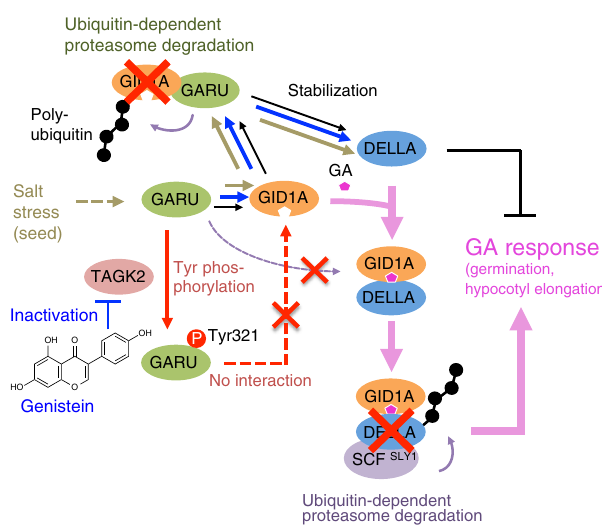
Fig. 8 A proposed model for control of GID1A protein stability by GARU- dependent ubiquitination and TAGK2-dependent Tyr phosphorylation. GARU induces ubiquitin-dependent proteasome degradation of GID1A (black lines). Destabilization of GID1A causes the stabilization of the DELLA, and GA signal is suppressed. However, GARU cannot ubiquitinate GA – GID1A – DELLA complex (purple dotted line), indicating that GA- dependent complex formation is more predominant than GID1A degradation by GARU. GARU – GID1A interaction is regulated by TAGK2- dependent Tyr phosphorylation of Tyr321 residue on GARU (red lines). In addition, GNS strongly inhibits the activity of TAGK2 and thereby induces stabilization of DELLA by GARU-dependent GID1A degradation (blue lines). the salt stress through the degradation of GID1 protein (brown